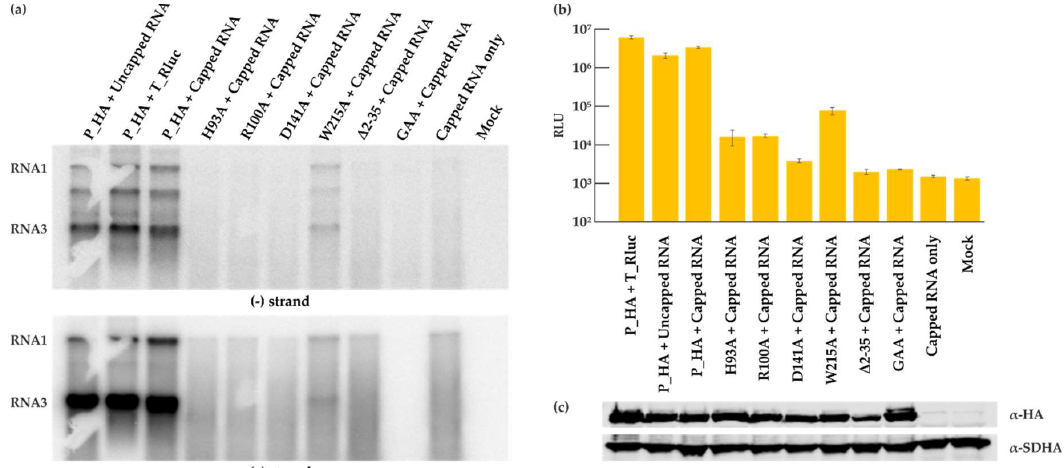
Figure 5. Capped RNA does not rescue the replication of the capping enzyme mutants. BSR T7/5 cells were co-transfected with the indicated FHV protein A constructs and either T_Rluc DNA or an in vitro transcribed FHV_T RNA template (capped or uncapped as indicated). ( a ) Viral RNA synthesis was detected by Northern blotting for minus and plus strands. ( b ) Rluc activity was measured 40 h post-transfection and the error bars represent the standard deviation. The data shown is a representative experiment. ( c ) Expression of protein A as detected by Western blotting with anti-HA antibodies; SDHA was used as a control. Note the slightly different sample order between panel ( a ) and panels ( b ) and ( c ).